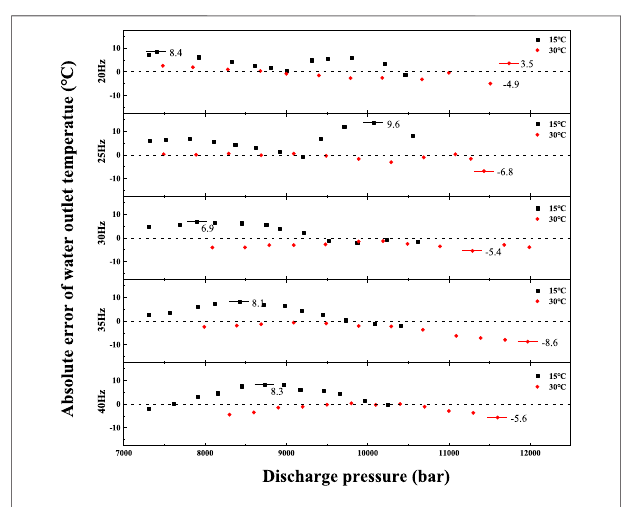
FIGURE 11 | Relative error of GCW